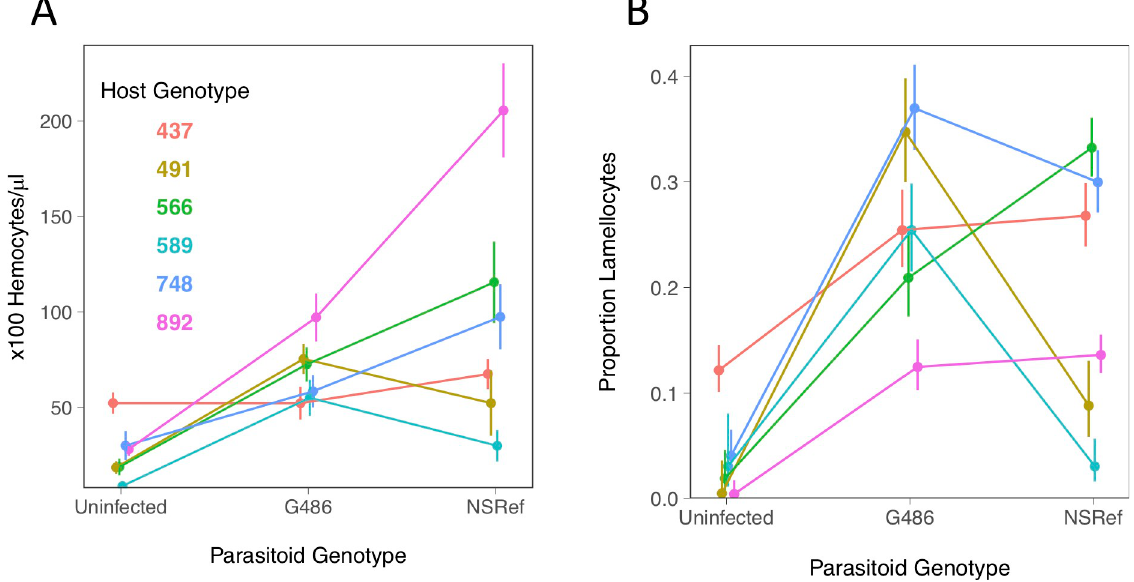
Fig 2. Cellular immune response of six Drosophila genotypes to two parasitoid genotypes. (A) The concentration of circulating hemocytes in control and infected Drosophila larvae. (B) The proportion of circulating hemocytes that are lamellocytes in control and infected Drosophila larvae. The lamellocyte proportions are coefficients estimated from a GLM. Bars are standard errors. There are a mean of 10.7 hemocyte counts per data point (each involved bleeding 10–12 larvae; full details are in S1